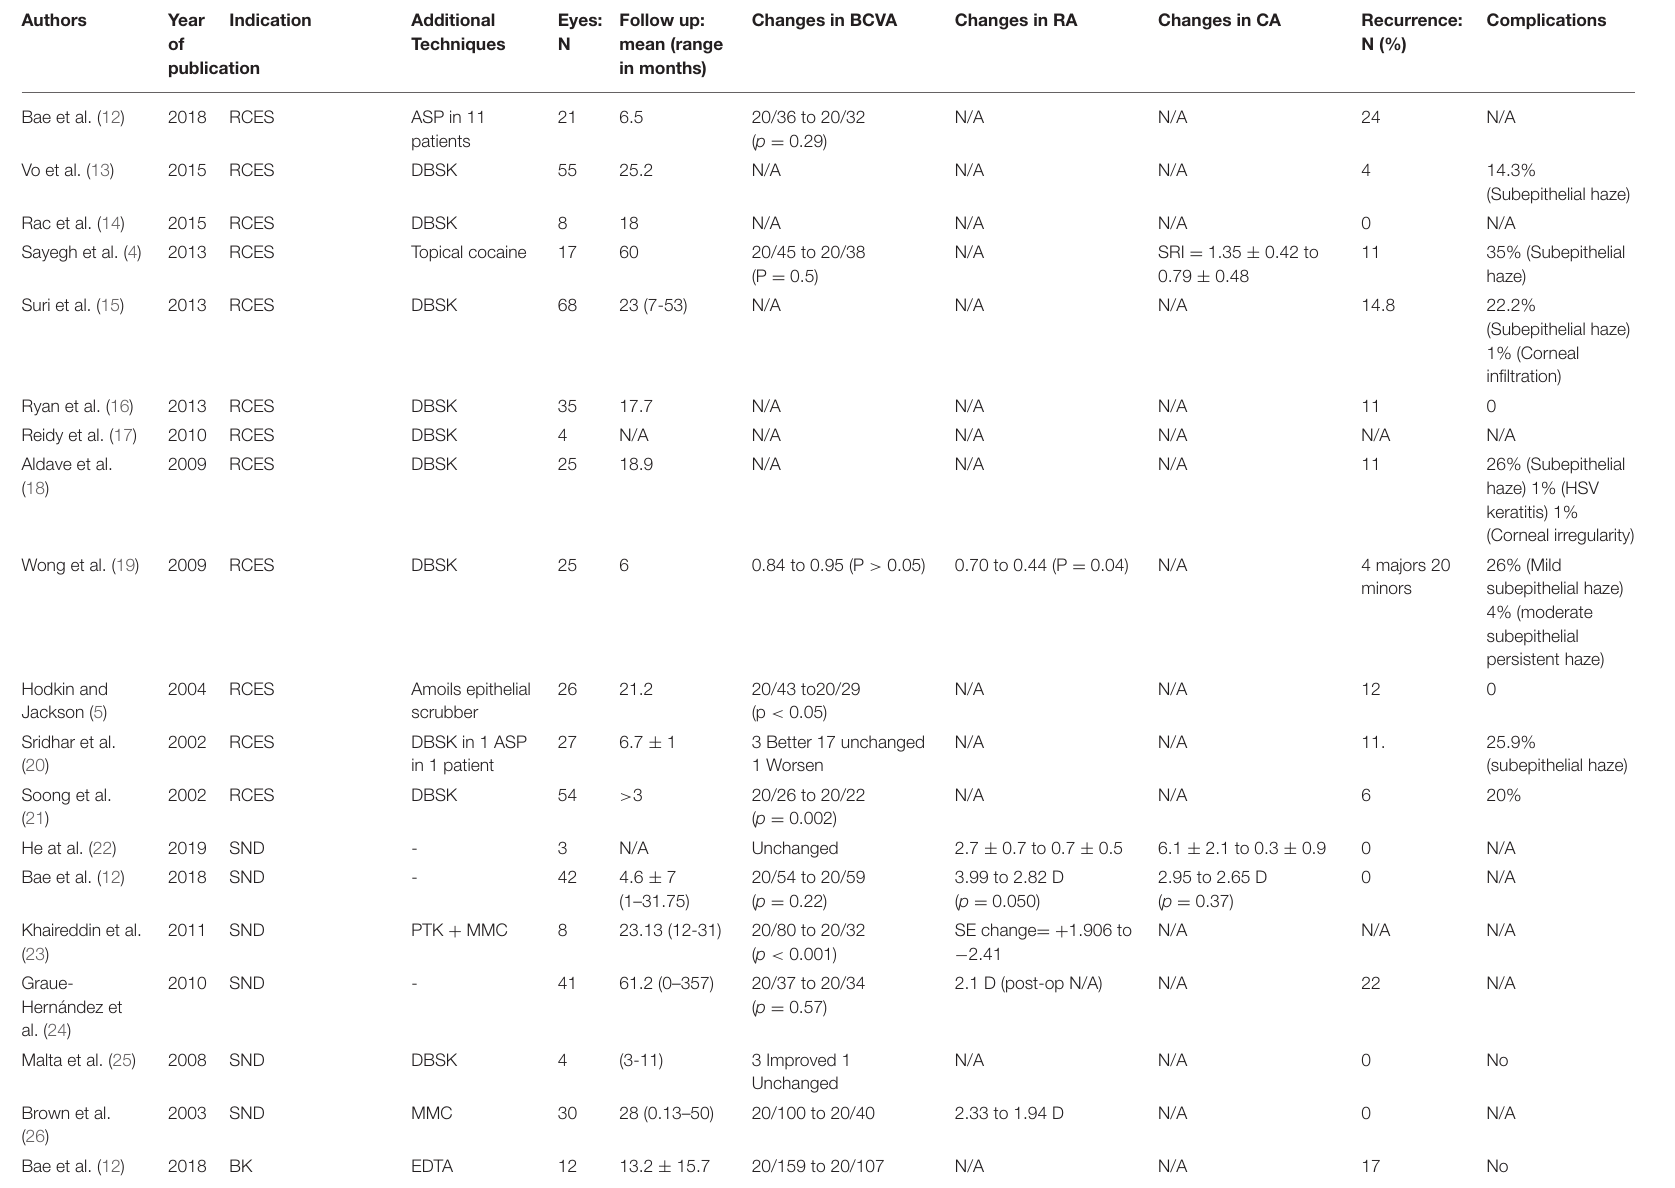
TABLE 2 | Outcomes of superficial keratectomy for different